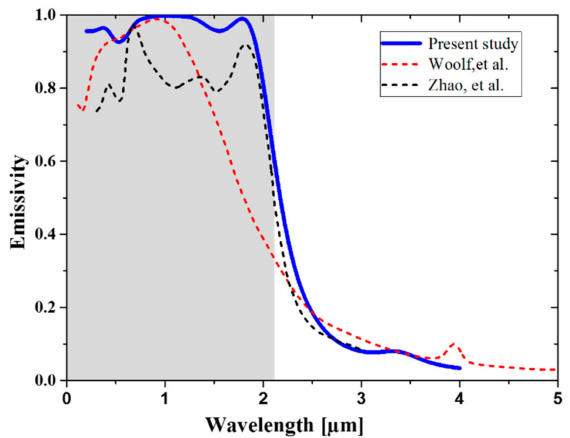
Figure 6. Comparison of the spectral emissivity of the proposed metamaterial (blue line), the external quantum efficiency (EQE) of InGaAs thermophotovoltaic (TPV) cells (shaded area), and results from